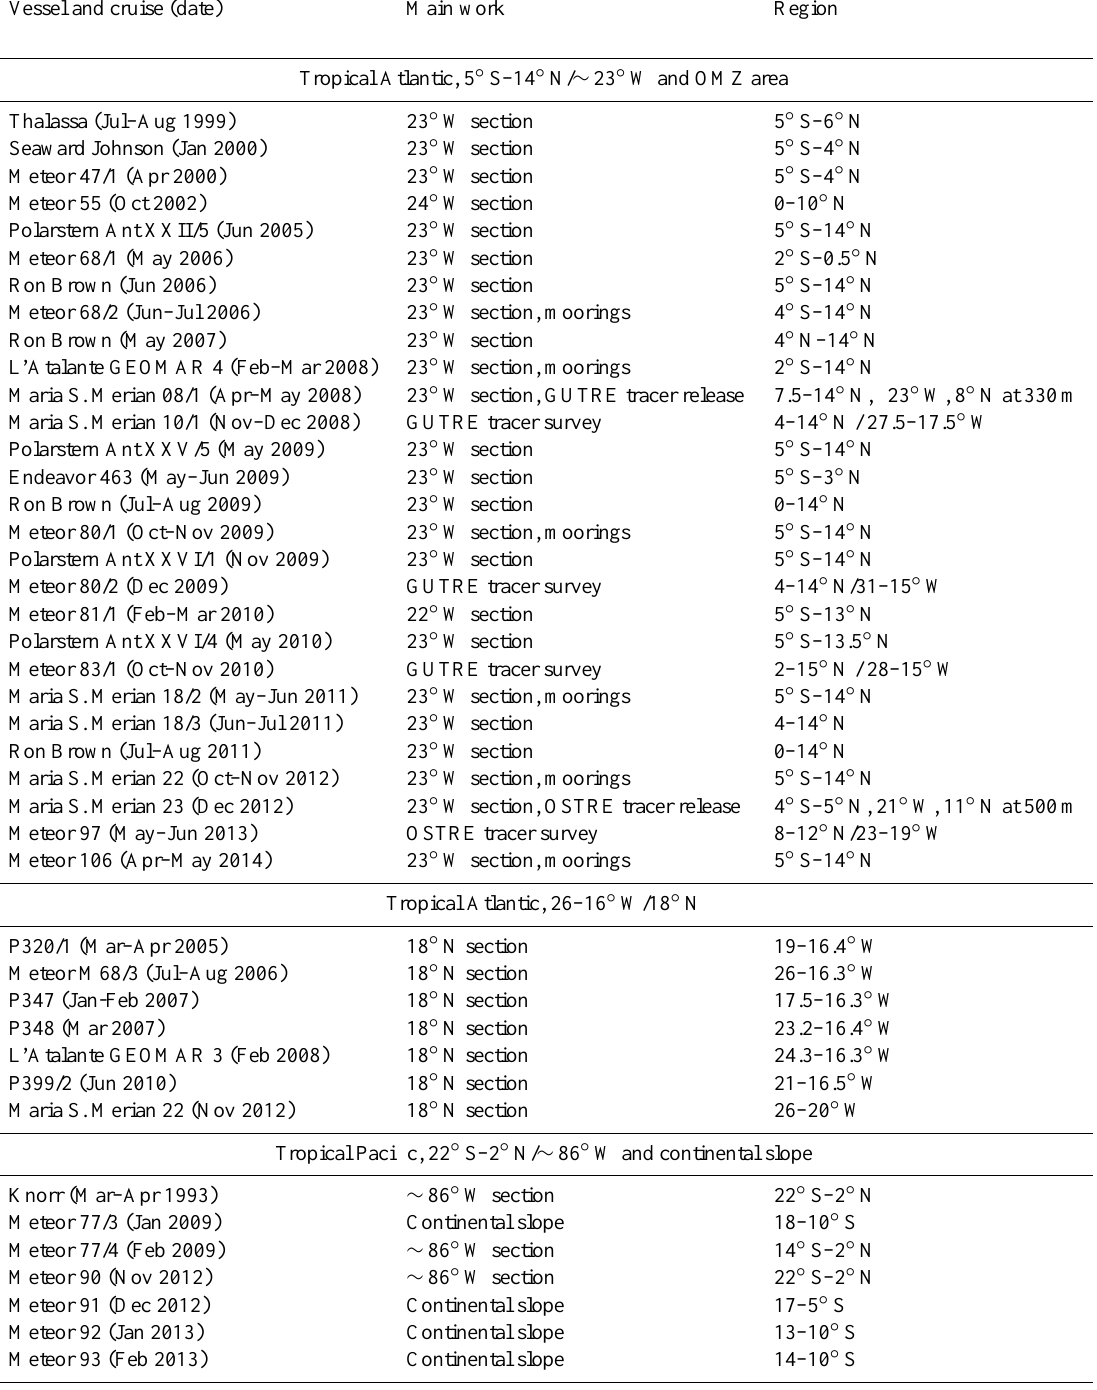
Table 1. Research cruises to the tropical eastern Atlantic and Pacific oceans. Depending on the measurements carried out and the geographical area covered on the different cruises, up to 22 sections were used to determine the mean 23 ◦ W section, 7 sections for the mean 18 ◦ N section and 3 sections for the mean ∼ 86 ◦ W